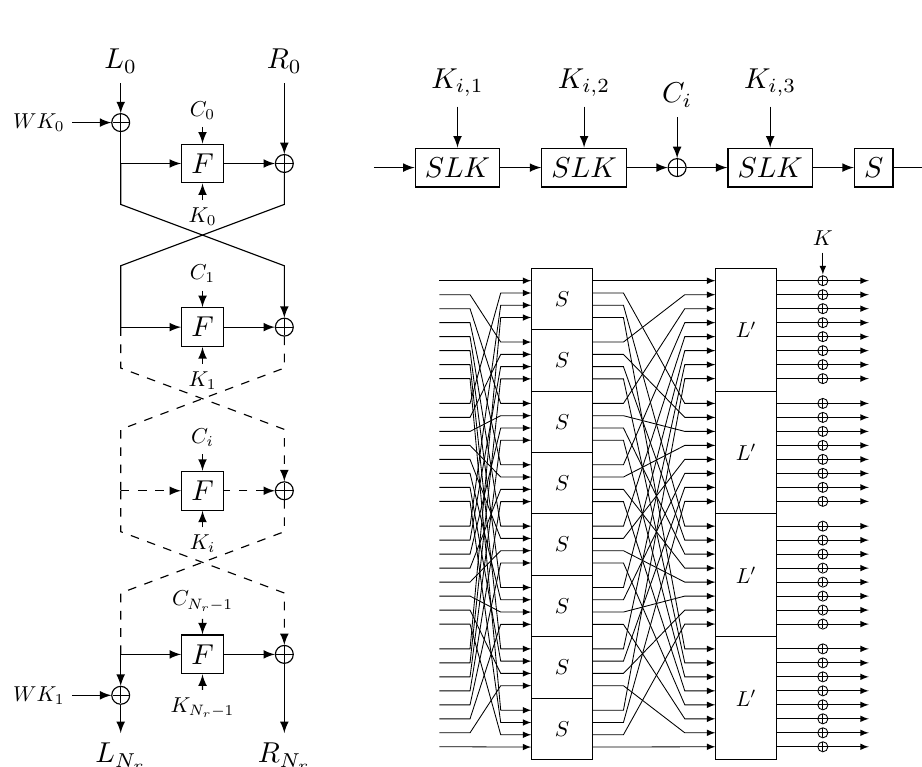
Figure 3: Overview of the RoadRunneR block cipher. Left: Feistel network with whitening keys xored in the first and last round. Top right: The round function F , taking in as input a 32-bit word, a 32-bit constant and a 96-bit round key. Bottom right: The core SLK function, which consists of an S-box layer followed by a linear diffusion layer and finally a key